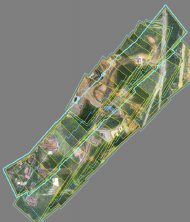
Figure 3. Overlapped UAV Images at the Study